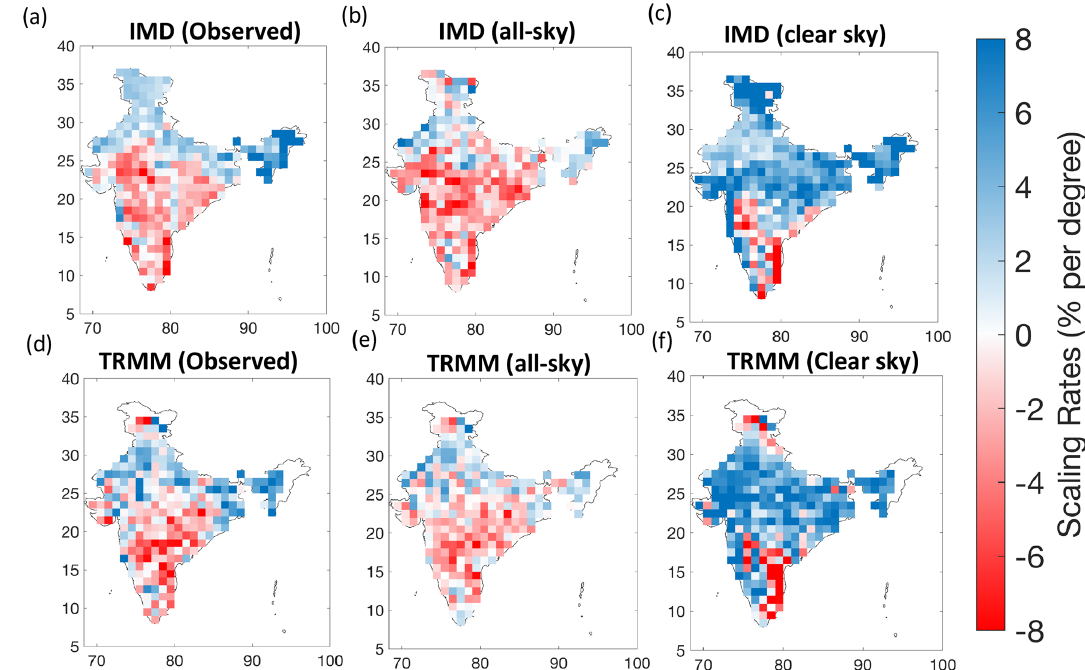
Figure 6. Regional variation of the 99th percentile precipitation–temperature scaling rates using daily (a–c) and 3-hourly (d–f) rainfall data with observed temperatures (a, d) , all-sky temperatures (b, e) and clear-sky temperatures (c, f)